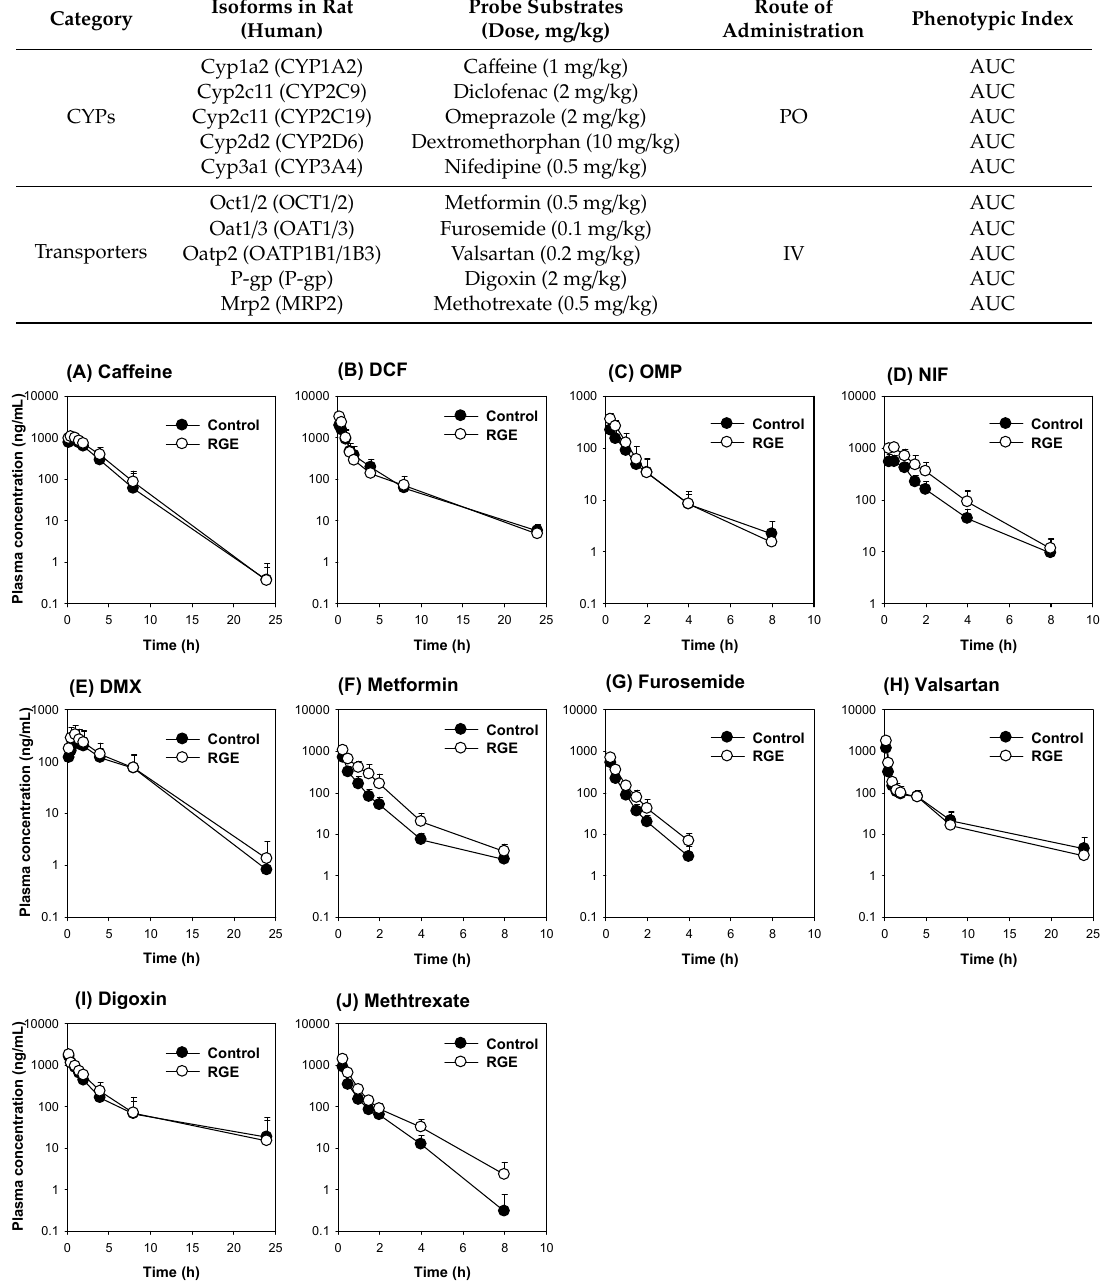
Figure 6. The plasma concentrations of ( A ) caffeine, ( B ) diclofenac (DCF), ( C ) omeprazole (OMP), ( D ) nifedipine (NIF), ( E ) dextromethorphan (DMX), ( F ) metformin, ( G ) furosemide, ( H ) valsartan, ( I ) digoxin, and ( J ) methotrexate following the repeated RGE administration (1.5 g/kg/day for 7 days) in rats that received dual cocktail sets. Dual cocktail set is composed of a mixture of CYP and transporter cocktails. The CYP cocktail consists of caffeine (1 mg/kg), diclofenac (2 mg/kg), omeprazole (2 mg/kg), nifedipine (0.5 mg/kg), and dextromethorphan (10 mg/kg) and orally administered. The transporter cocktail mixture is composed of metformin (0.5 mg/kg), furosemide (0.1 mg/kg), valsartan (0.2 mg/kg), digoxin (2 mg/kg), and methotrexate (0.5 mg/kg) and administered via intravenous injection. The data are presented as the means ± SD ( n = 7) .